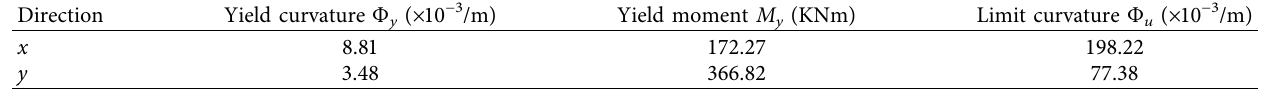
Table 9: Salient points in the moment-curvature relationships for the piers.